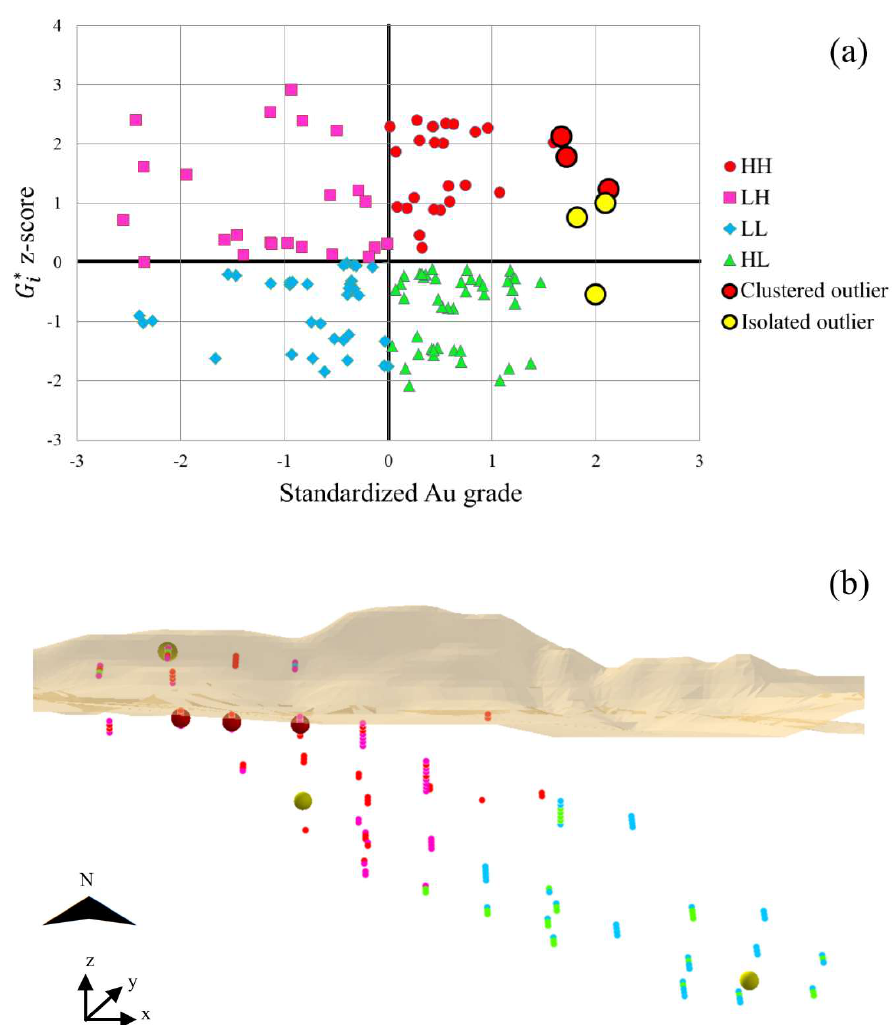
Figure 5. ( a ) Classification of outliers by considering hot spot analysis and ( b ) the result displayed in three dimensions.